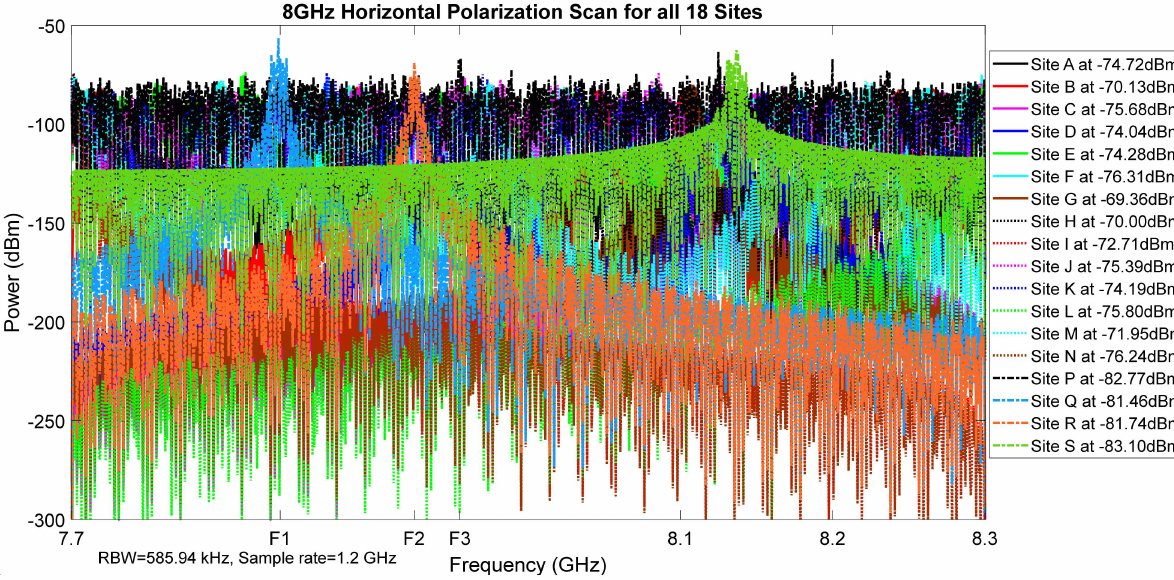
Figure 45. The 8 GHz horizontal polarization scan for all sites after denoising and applying the algorithm to all sites, including those without the potential to cause